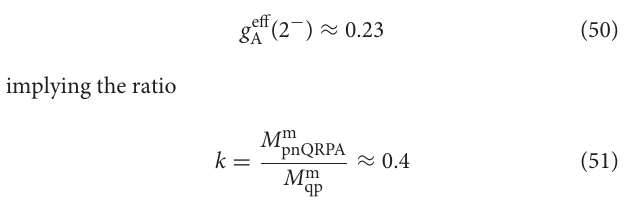
g V needed to reproduce the =